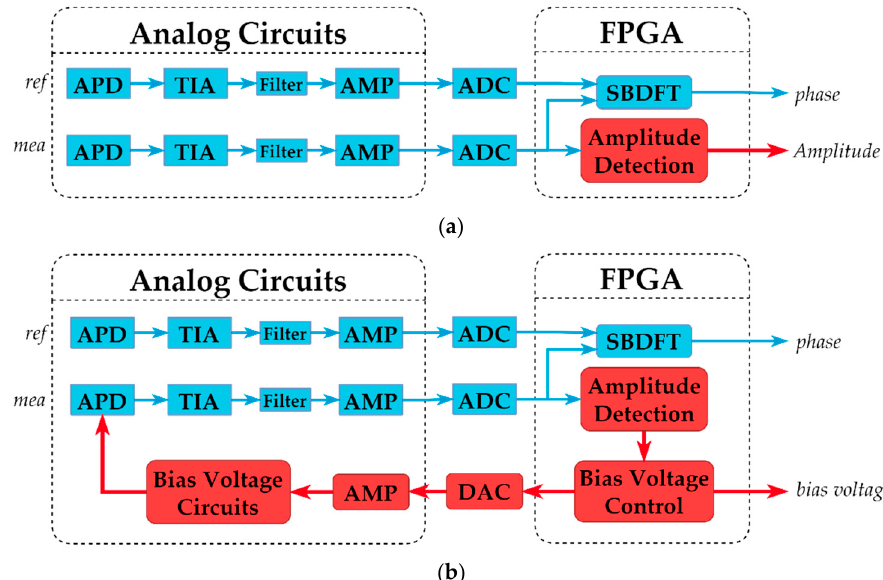
Figure 6. Schematic of two detection methods: ( a ) best-gain detection method; ( b ) auto-gain detection method.